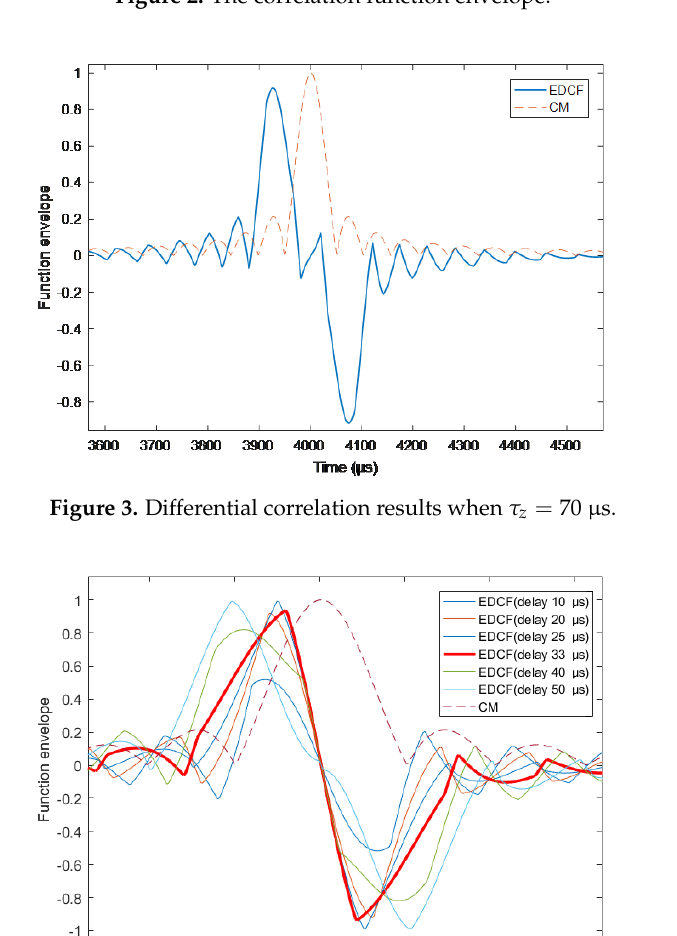
Figure 2. The correlation function envelope.